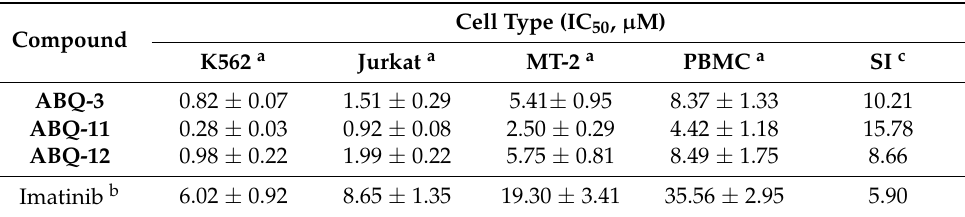
Table 1. The anticancer effects of ABQ-3 , ABQ-11 , and ABQ-12 on cancer and healthy cells compared to